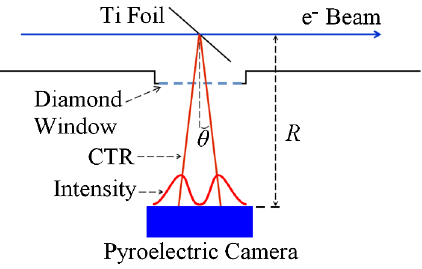
FIG. 1. Setup diagram for the spatial distribution measurement of CTR.